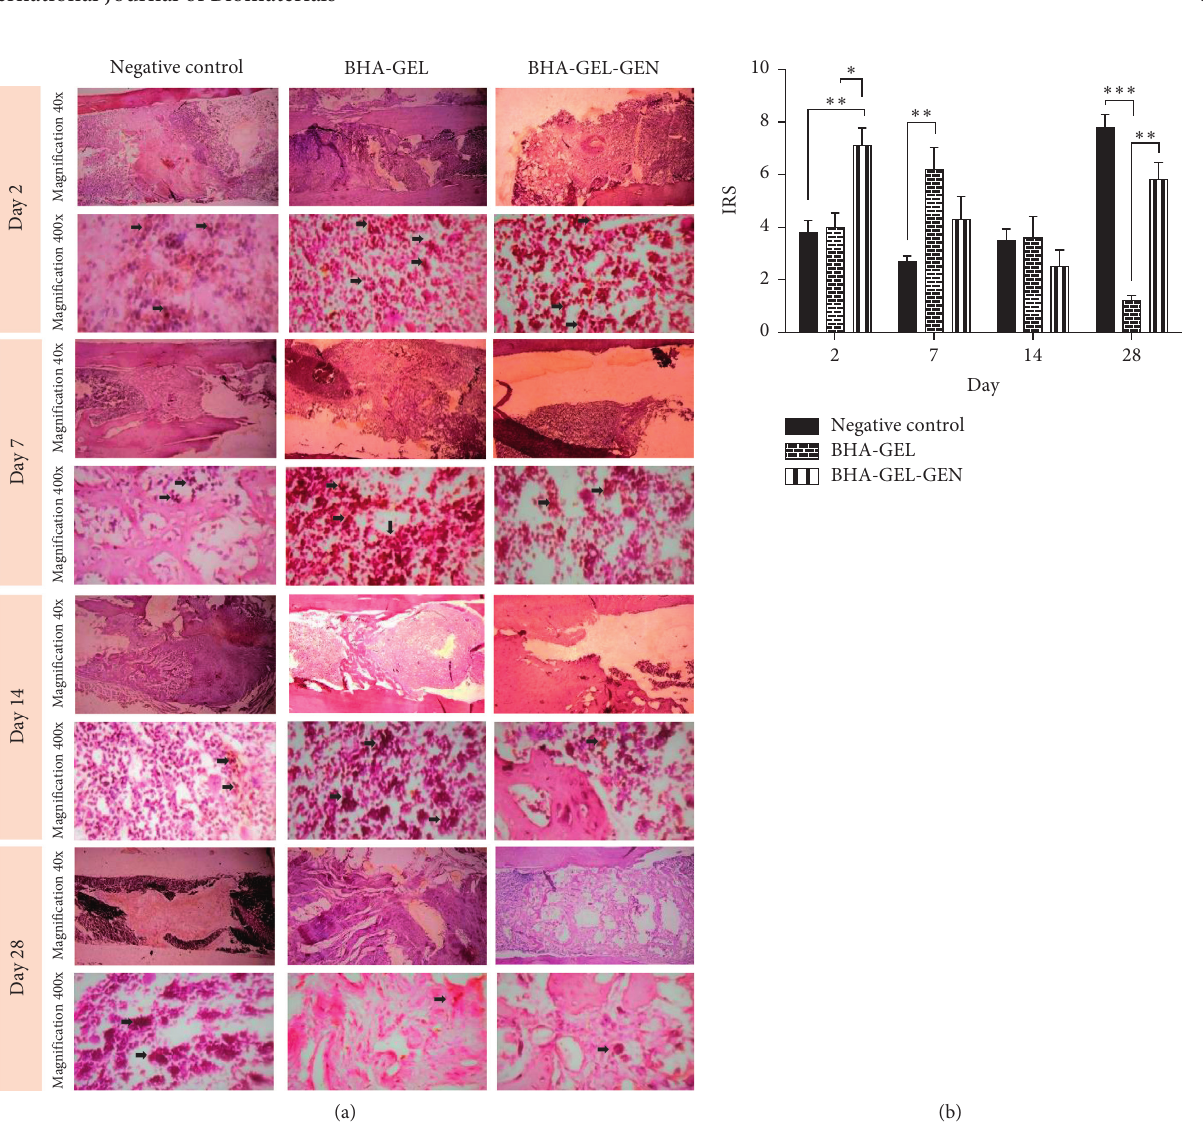
Figure 3: (a) Tangential longitudinal section of rat’s femur stained with anti-VEGF. Osteoblasts expressing VEGF (black arrow). (b) Immunoreactive score (IRS) of VEGF in each group. Each bar represents the mean IRS ± SEM of the two rats observed in at least two different visual fields. ∗ P � 0 . 05, ∗∗ p < 0 . 05, ∗∗∗ p < 0 . 001 with Kruskal